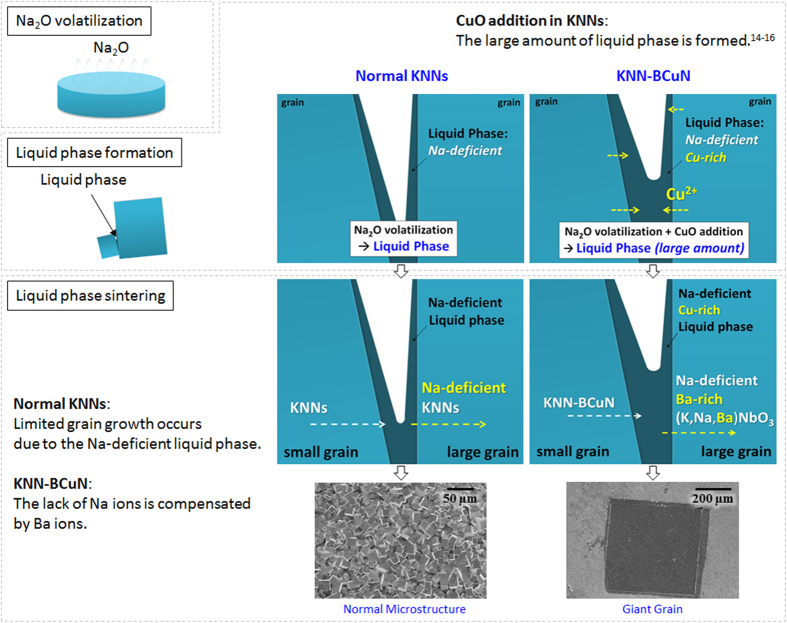
Difference between (K0.5Na0.5)NbO3-based ceramics (KNNs) and 0.985(K0.5Na0.5)NbO3-0.015Ba(Cu1/3Nb2/3)O3 ceramics (KNN-BCuN) in sintering behavior: While the grain growth appears to be limited due to the Na-deficient liquid phase in KNNs, the lack of Na ions is compensated by Ba ions in KNN-BCuN.